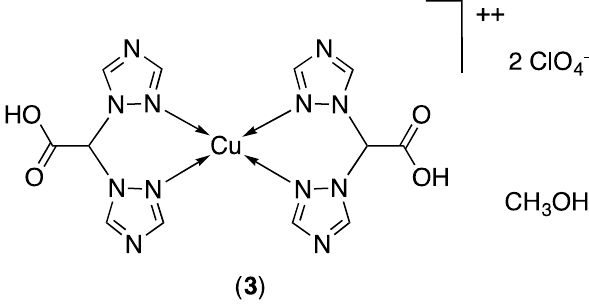
Figure 2. Proposed structure of compound 3 .